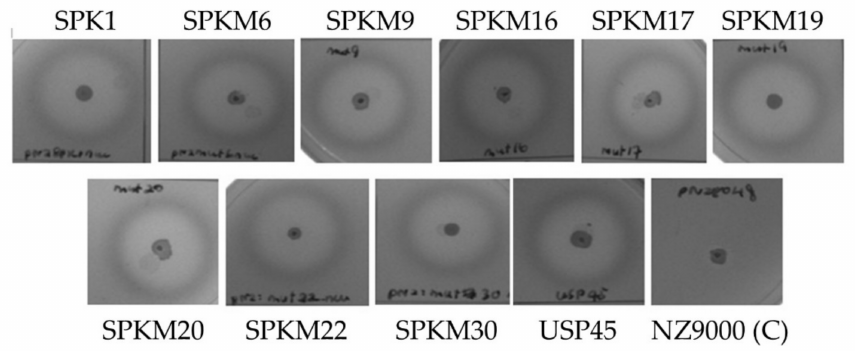
Figure 4. Nuclease activity plate assay showing halo zones’ formation of secreted NUC surrounding the colonies of recombinants L. lactis . The NZ9000 with empty plasmid pNZ8048 was used as a negative